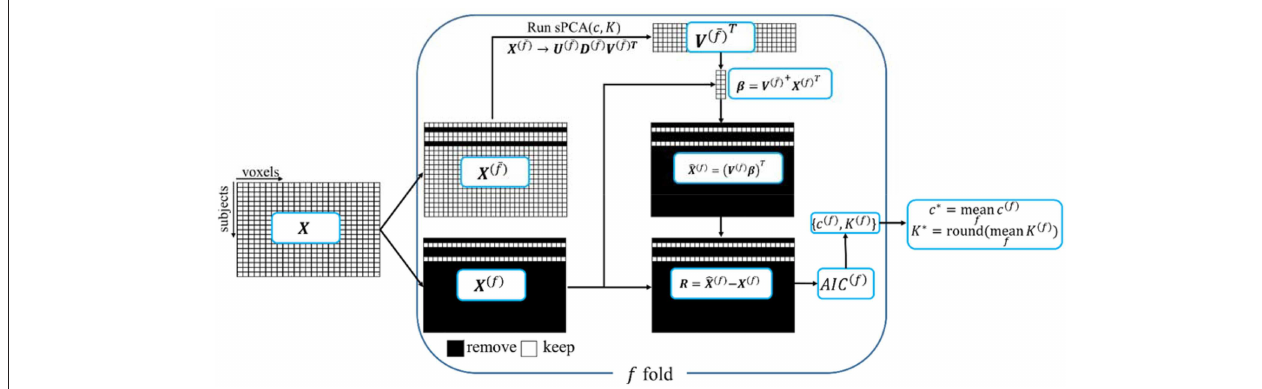
FIGURE 1 | A schematic diagram of the split-sample cross-validation method in sPCA. X is the data matrix. Each subject is randomly assigned to one fold, X ( f ) denotes the data from the subjects assigned in f -fold data and X ( f ) denotes the data with X ( f ) excluded. The “ + ” superscript indicates the Moore-Penrose pseudoinverse.